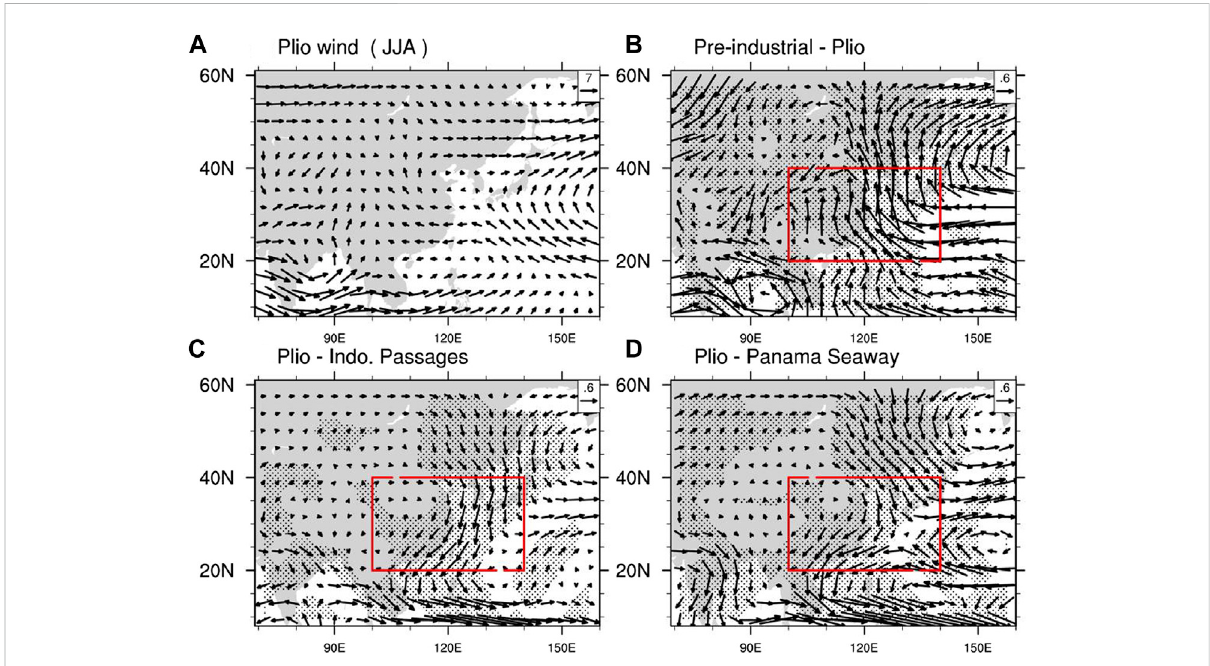
FIGURE 6 Climatological June-July-August (JJA) mean 850 hPa winds for (A) Plio, and its responses to (B) decreasing CO 2 , (C) the constriction of the IndonesianPassagesand (D) theclosureofthePanamaSeaway.RedboxesindicatetherangeofEASM(20 ° N-40 ° N,100 ° E-140 ° E).Windvectorscales (Unit: m/s) are shown in the upper right corner of each panel. Stippling indicates the differences for meridional wind are signi fi cant at the 95% con fi dence level using Student ’ s